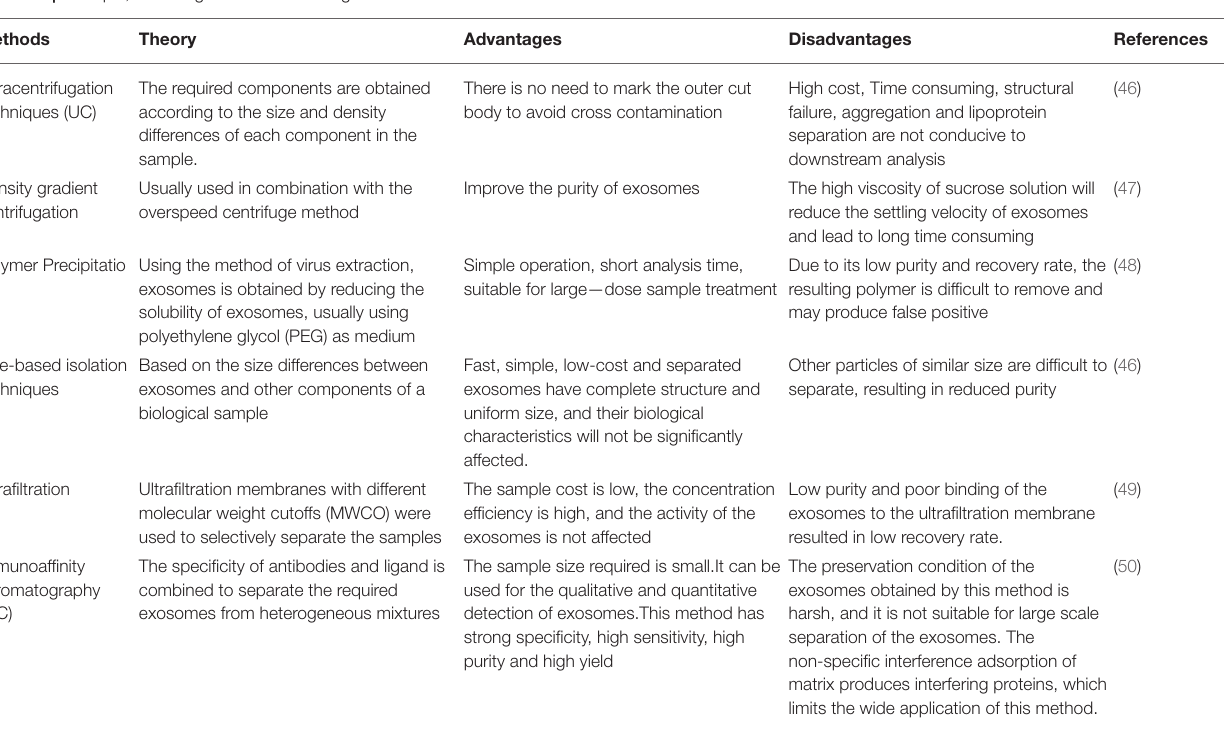
TABLE 3 | Principle, advantages and disadvantages of common exosome isolation